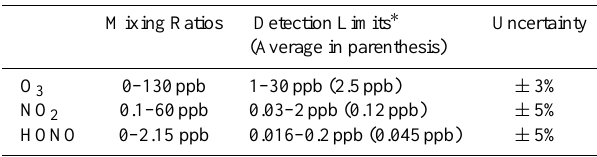
Table 1. Observed mixing ratio ranges and detection limits during TRAMP